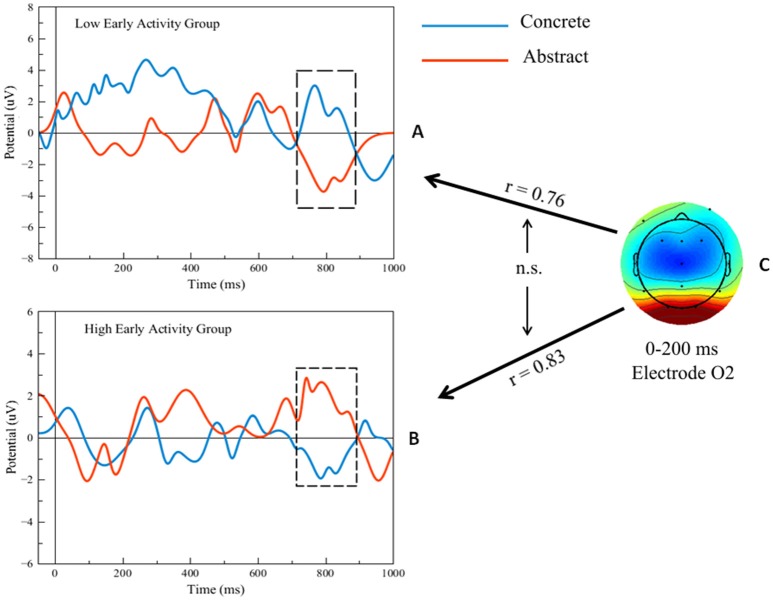
(A,B) Filtered single-trial ERP waveforms during the concrete vs. abstract word-verification task in high and low early activity groups. (C) Scalp map of single-trial ERP activity during the attention task and representation of predictions (black arrows) of the ERP differences in the regions shown by the black outline frames. Bidirectional black arrows represent statistical comparison (“n.s.”: non-significant).